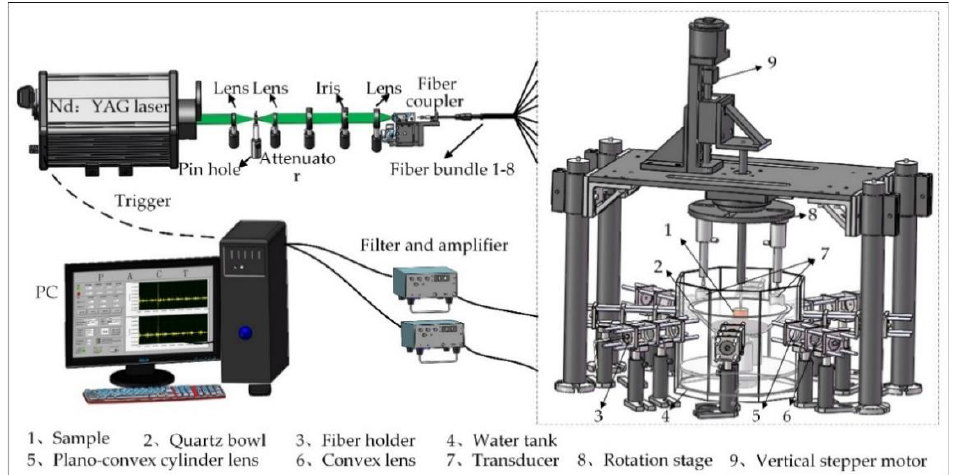
Figure 1. Schematic of the 3D-PACT system.